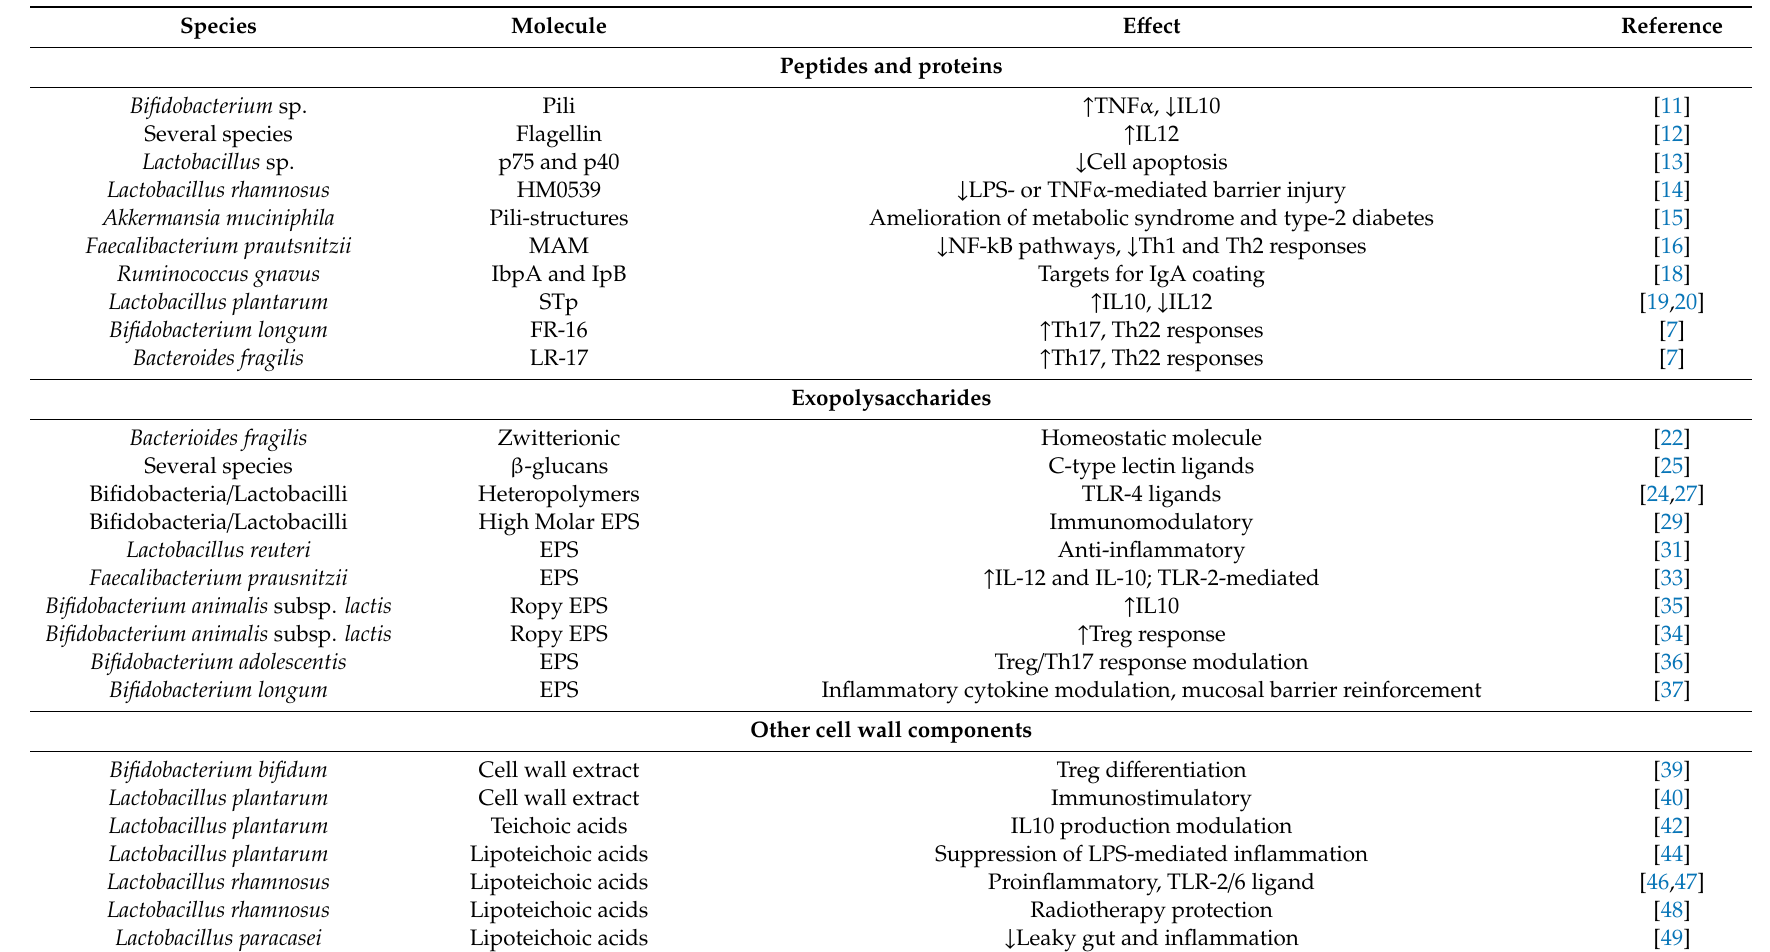
Table 1. Immunomodulatory molecules and compounds discussed in this